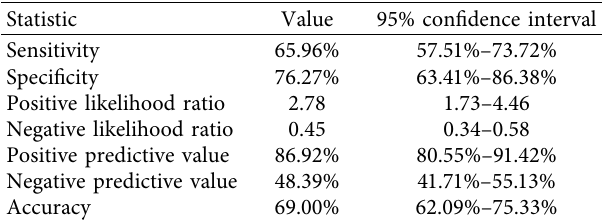
Table 2: Prognostic value of presence of CTscan finding (total) for poor final visual acuity in patients with traumatic eye injury using the binary cross tab model.